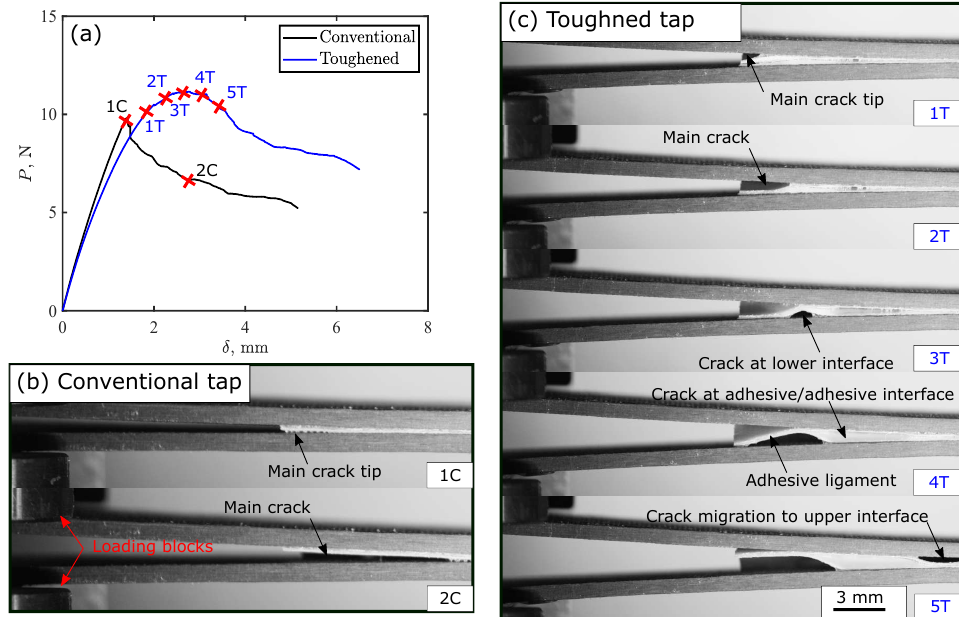
Figure 10. Experimental evolution of toughening mechanisms in thermoplastic adhesive tapes with 2 mm crack length and 5 mm gap between cracks: ( a ) load-displacement curves for DCB test; and crack propagation in ( b ) conventional tape, and ( c ) toughened